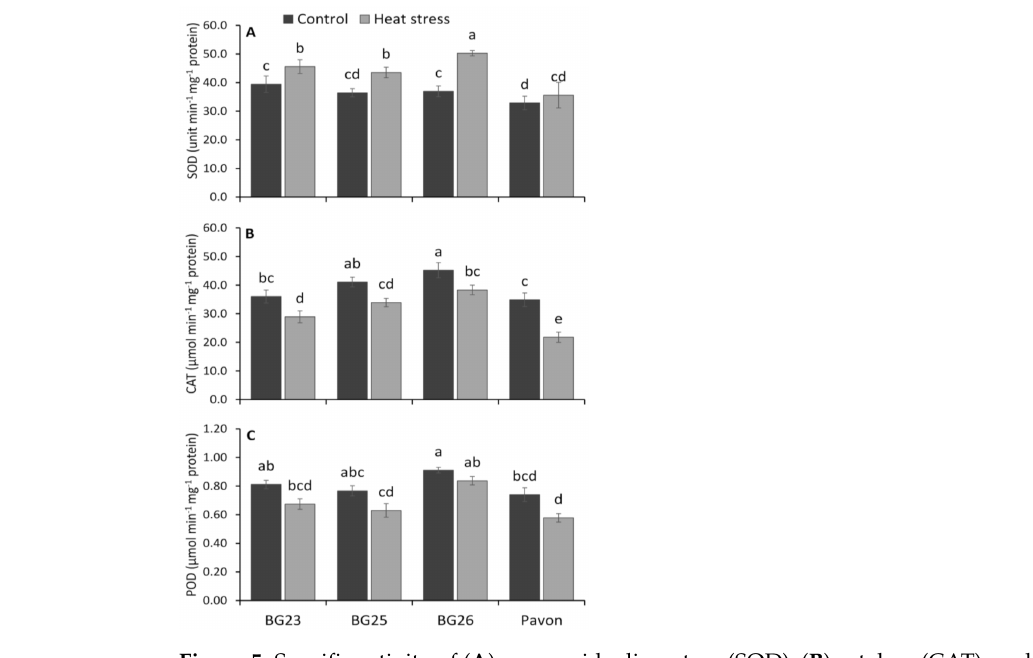
Figure 5. Specific activity of ( A ) superoxide dismutase (SOD), ( B ) catalase (CAT), and ( C ) guaiacol peroxidases (POD) enzymes of wheat varieties under control and heat-stressed conditions. Vertical bars represent +/ − SE values. Different letter(s) indicate significant difference at p < 0.05.